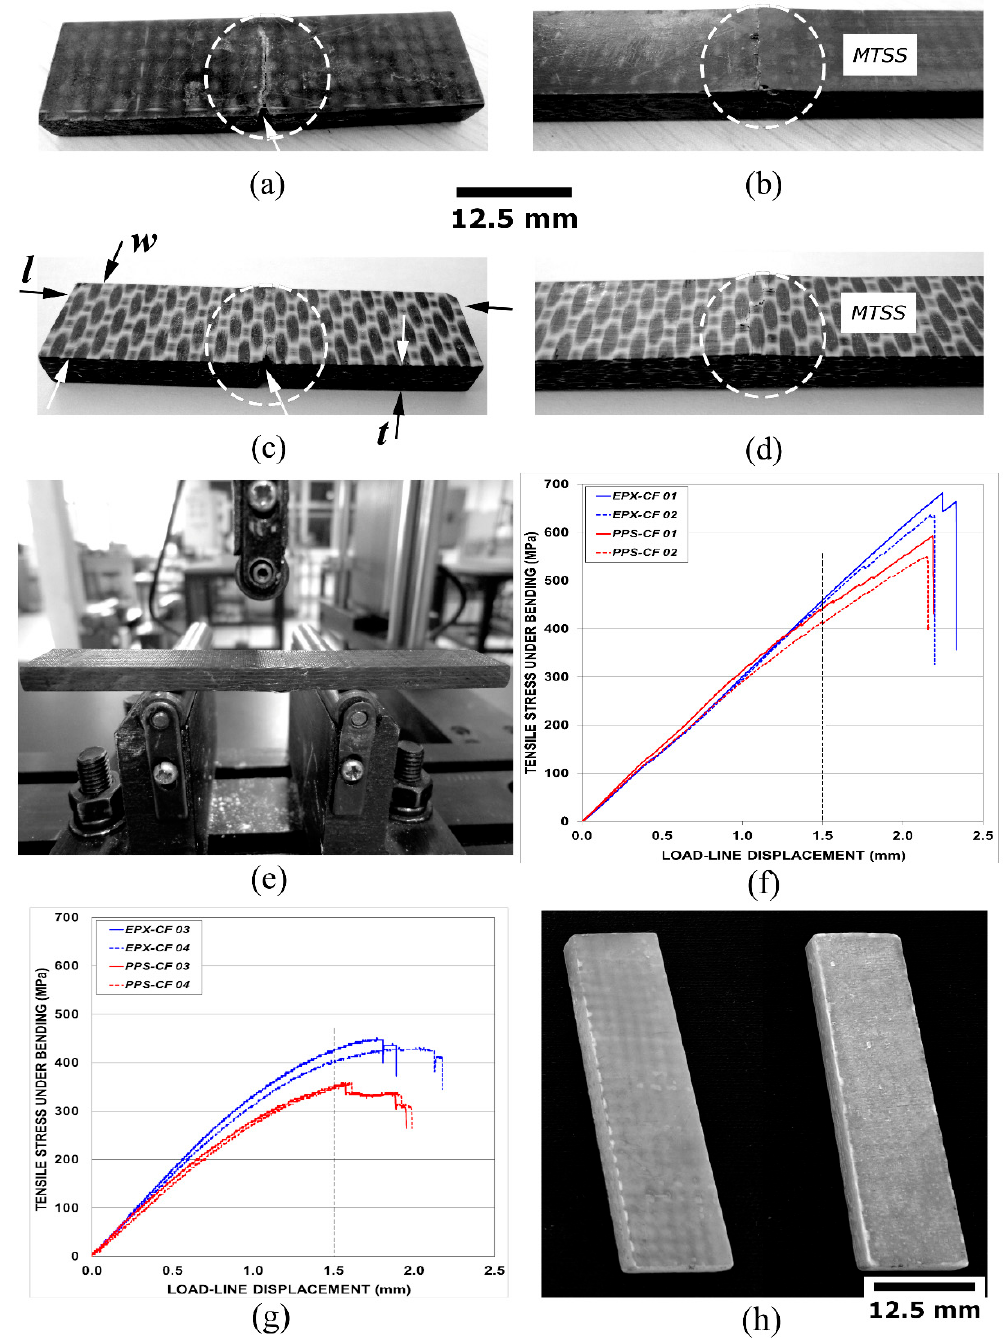
Figure 1. ( a , b ) Translaminarly cracked and delaminated carbon fibre-reinforced epoxy resin (EPX-CF) test coupons; ( c , d ) and the same for the carbon fibre-reinforced thermoplastic poly-phenylene sulphide (PPS-CF) specimens; ( e ) a three-point bending (3PB) setup supporting a delaminated specimen; ( f , g ) flexural loading plots for, respectively, delaminated and translaminarly damaged EPX-CF and PPS-CF test pieces; and ( h ) undamaged, but defective glass fibre-reinforced thermoset epoxy resin (EPX-GF) sample (front and back). Damaged regions are highlighted by dashed circles in ( a – d ). Respective surfaces experiencing maximum tensile stress (MTSS) are indicated in ( b , d ).